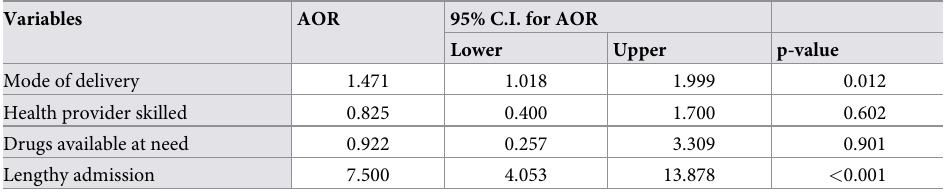
Table 5. Multivariable regression results for factors associated with the third maternal delay among pregnant women in Ilubabor zone, southwest Ethiopia, February to April 2021(n = 402).